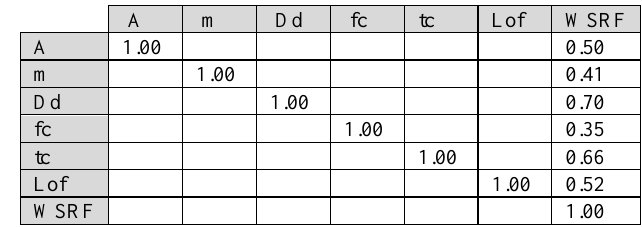
Table 2: Correlation A (Area), m (Slope), Dd (Density), fc (Frequency), tc (Time of concentration), Lof (Length of overflow)